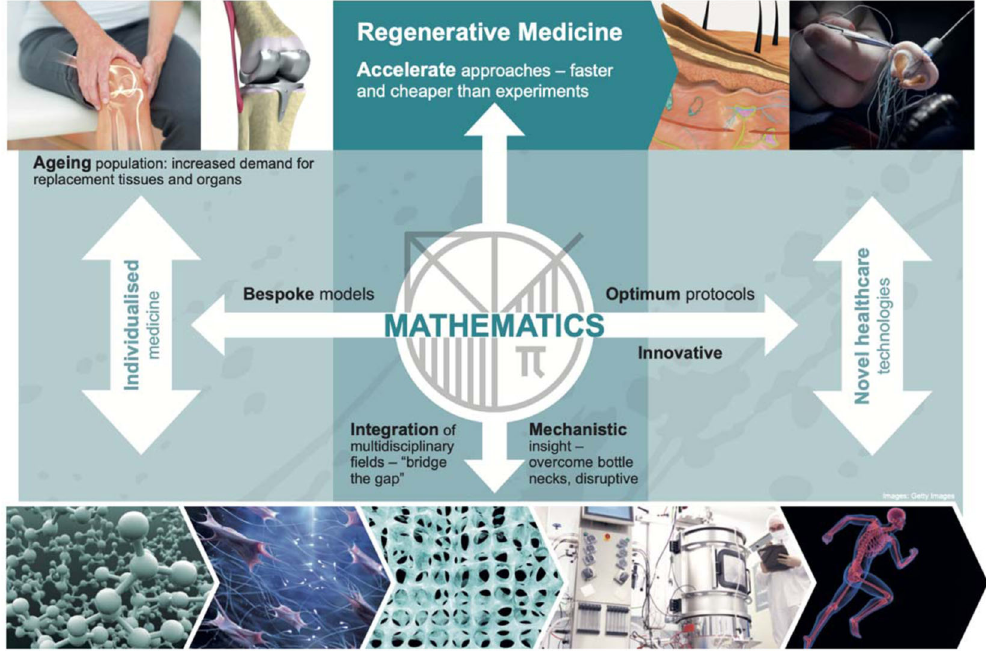
Fig. 1 A new era of symbiosis between regenerative medicine and maths. Diagram which highlights the many opportunities for utilising mathematical and computational approaches within regenerative medicine. This fi gure was created for the authors by the University of Edinburgh ’ s graphic design service team.